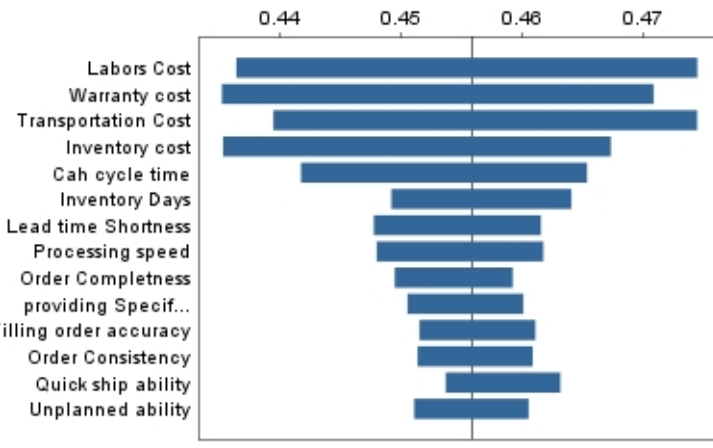
Figure 5. Tornado graph of criteria for expected value of supply chain